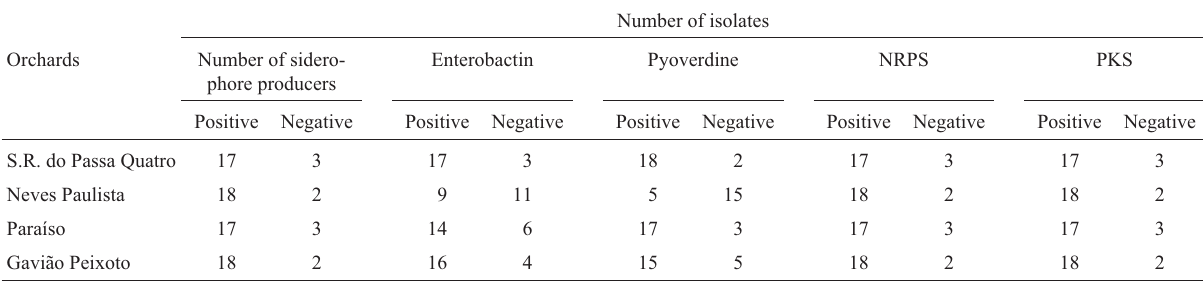
Table 3 - Screening of Xylella fastidiosa isolates for siderophore and genes associated with iron-uptake (enterobactin, pyoverdine-receptor, polyketide synthase (PKS) and non-ribosomal peptide synthetase (NRPS)).